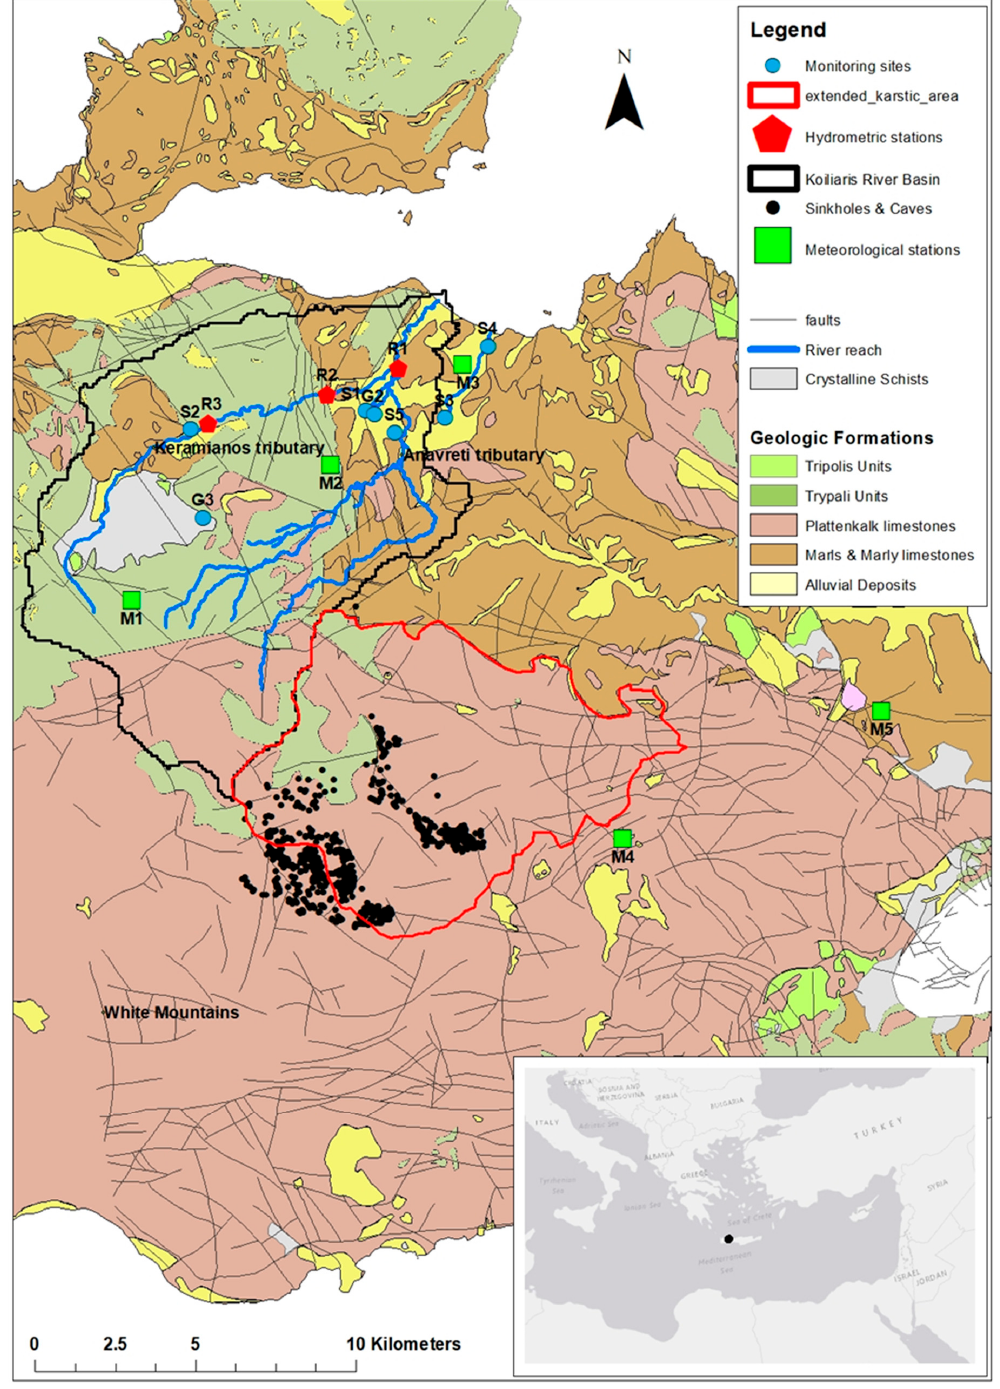
Figure 1. Schematic of the regional geology, the drainage network and the monitoring network of Koiliaris CZO.